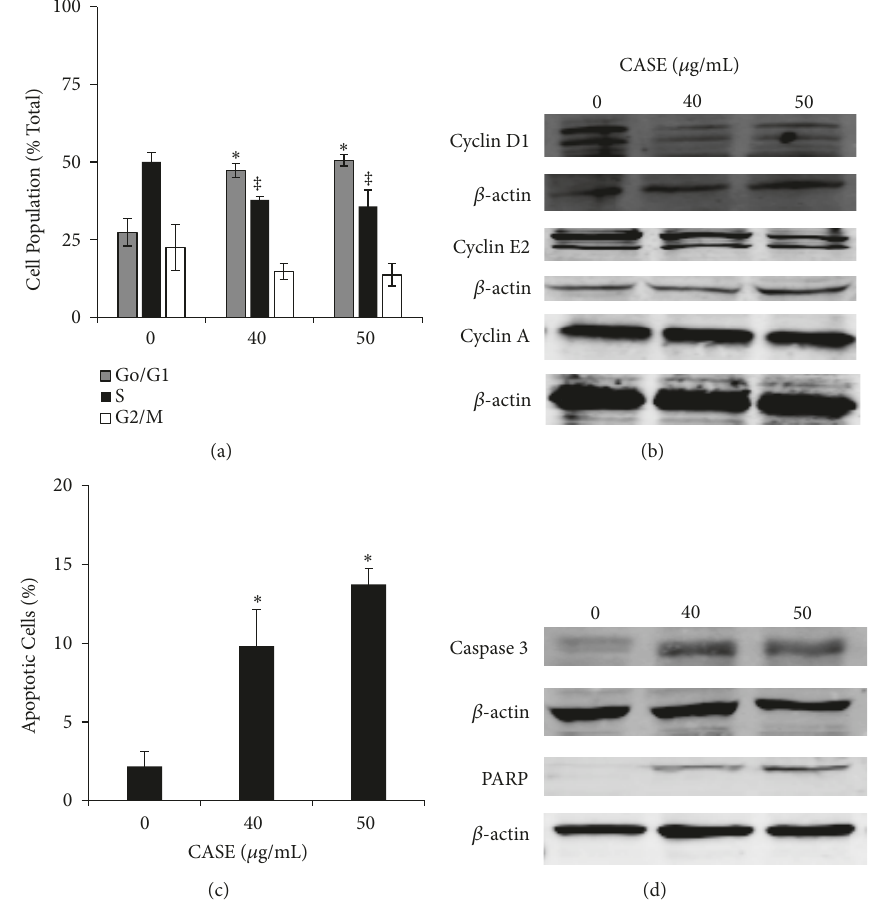
Figure 3: Induction of cell cycle arrest and apoptosis in LNCaP cells by CASE treatment. Cells were treated with CASE for 12 h. (a) Cells were fixed in methanol and stained with propidium iodide, and cell cycle analysis was performed using flow cytometry. (b) After 12 h treatment, the effect of CASE on the expression of cyclins was determined by western blot. Cyclin expression was normalized to expression of 𝛽 -actin. Following treatment with CASE for 12 h, (c) induction of apoptosis was determined by quantifying externalization of phosphatidylserine using flow cytometry and (d) determining the extent of caspase 3 and PARP cleavage using western blot. Cleaved caspase-3 and PARP levels were normalized to 𝛽 -actin. The blots shown are representativeof three independentexperiments. The bar graphs represent the mean of three independent experiments ±